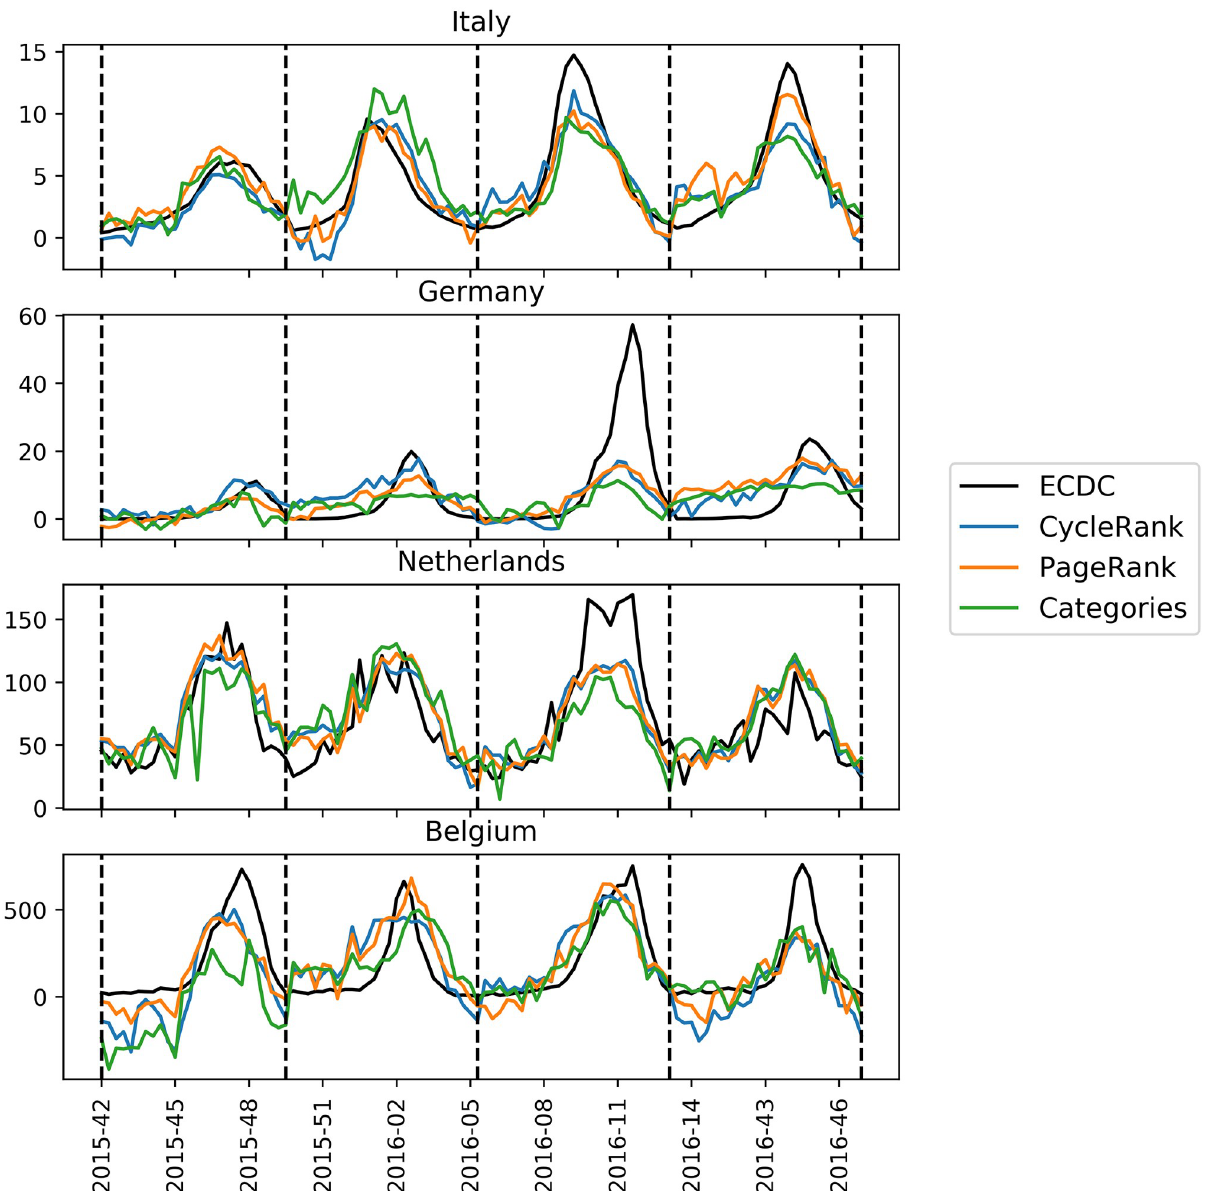
Fig 1. Best CycleRank , PPageRank and Categories LASSO models predictions on the Italian, German, Belgian and Dutch influenza incidence. The dashed lines delimit the various influenza seasons.